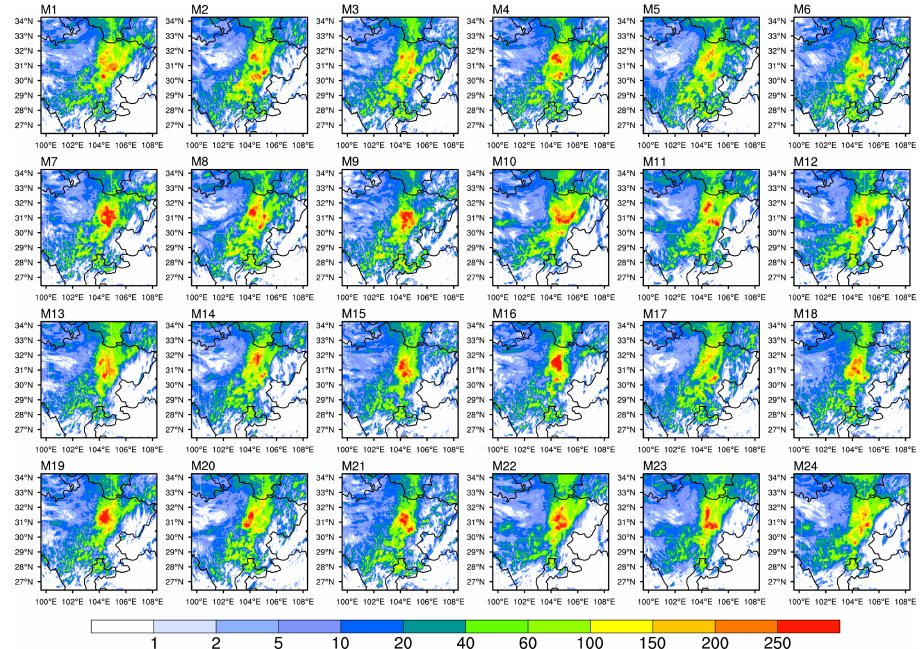
Figure A1. Maps of 24-h cumulative precipitation (mm) of M1–M24 for